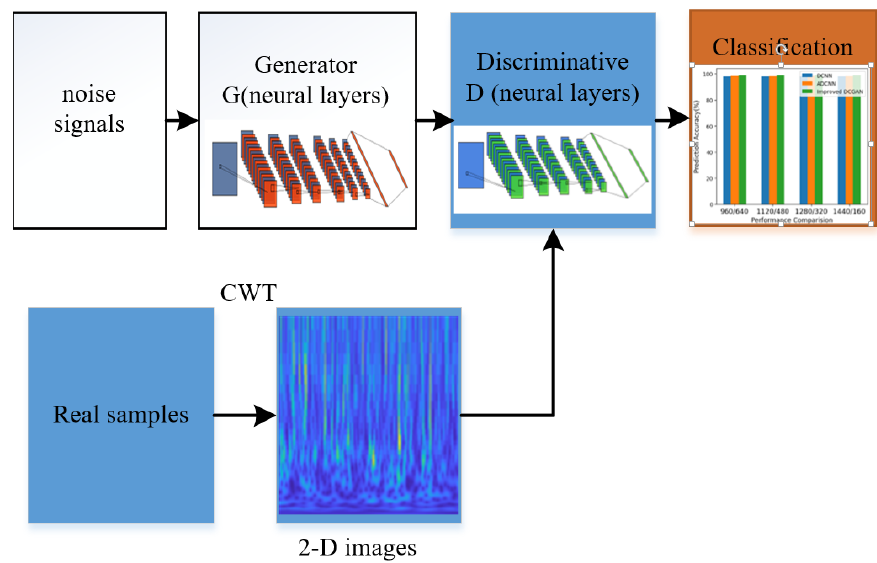
Figure 7. The whole experiment process for the proposed method.